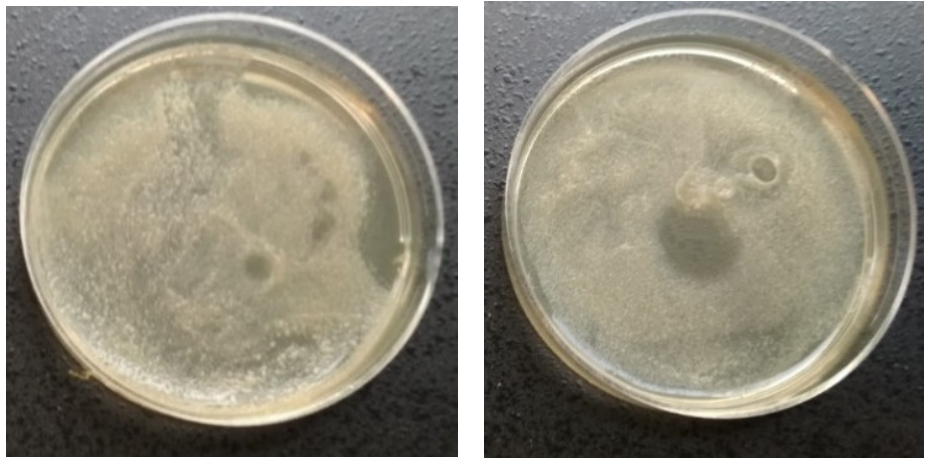
Figure 2. Comparison of inhibition zone sizes created by 10 s ( left ) and 120 s ( right ) plasma treatment with 9 W power after 48 h from the exposure of the undiluted culture.